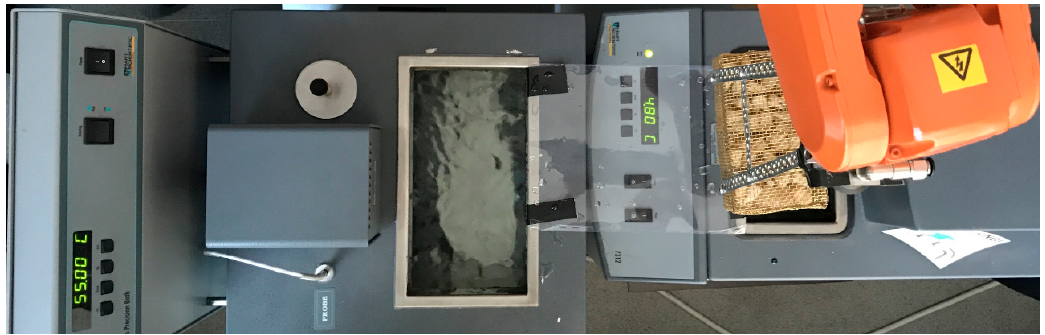
Figure 1. Submersion rig made from ABB robot and two Hart Scientific thermal baths.